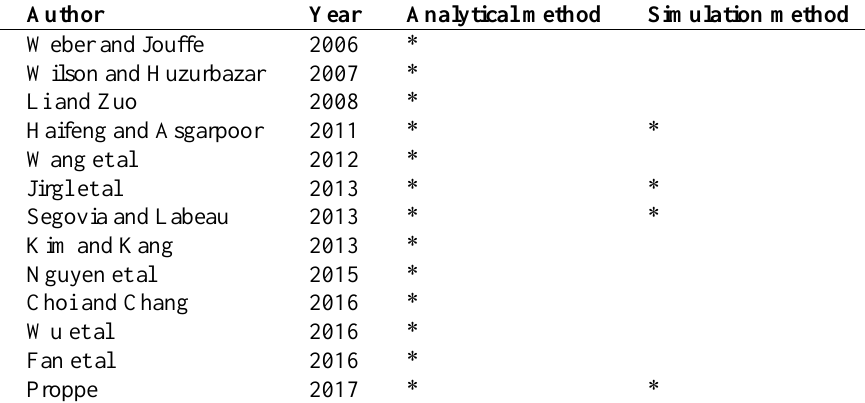
Table 1 . Methods to tackle the